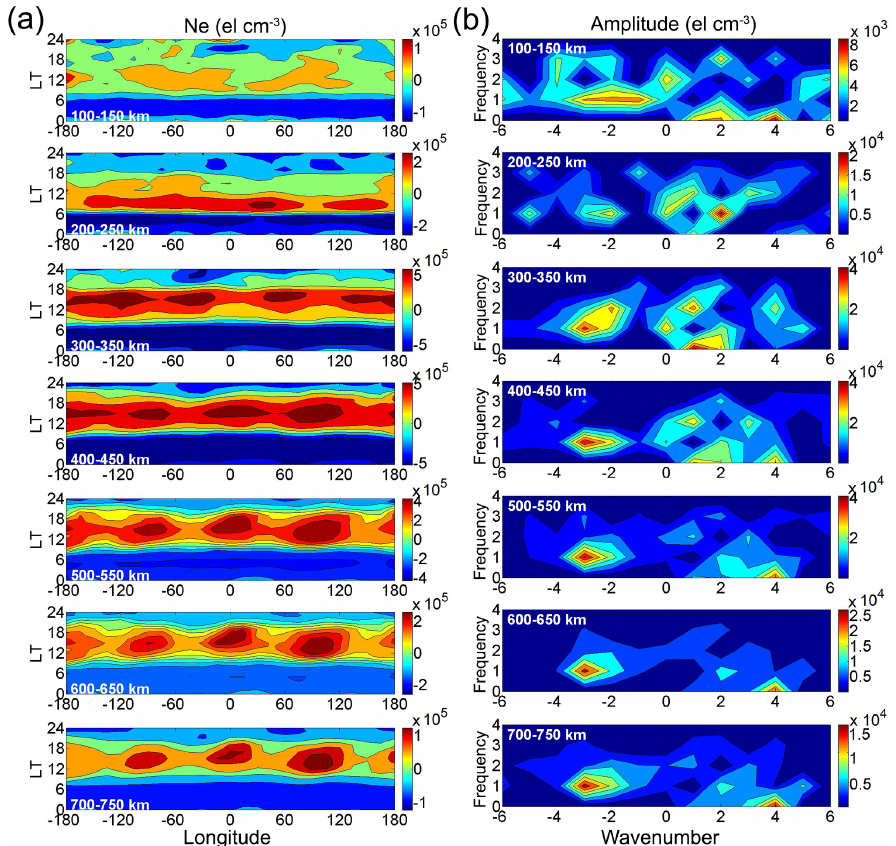
Figure 7. 2013 September equinox Ne LT contour plots. (a) LT × longitude contour plots for electron density (Ne) for some altitudes of the 50km interval, during the 2013 September equinox period. (b) Amplitudes obtained for non-migrating tides indicating their frequency (1/day) and respective zonal wavenumber. The corresponding altitude intervals used are indicated in the plots. The color scale, in elcm − 3 , is shown at the right side of each